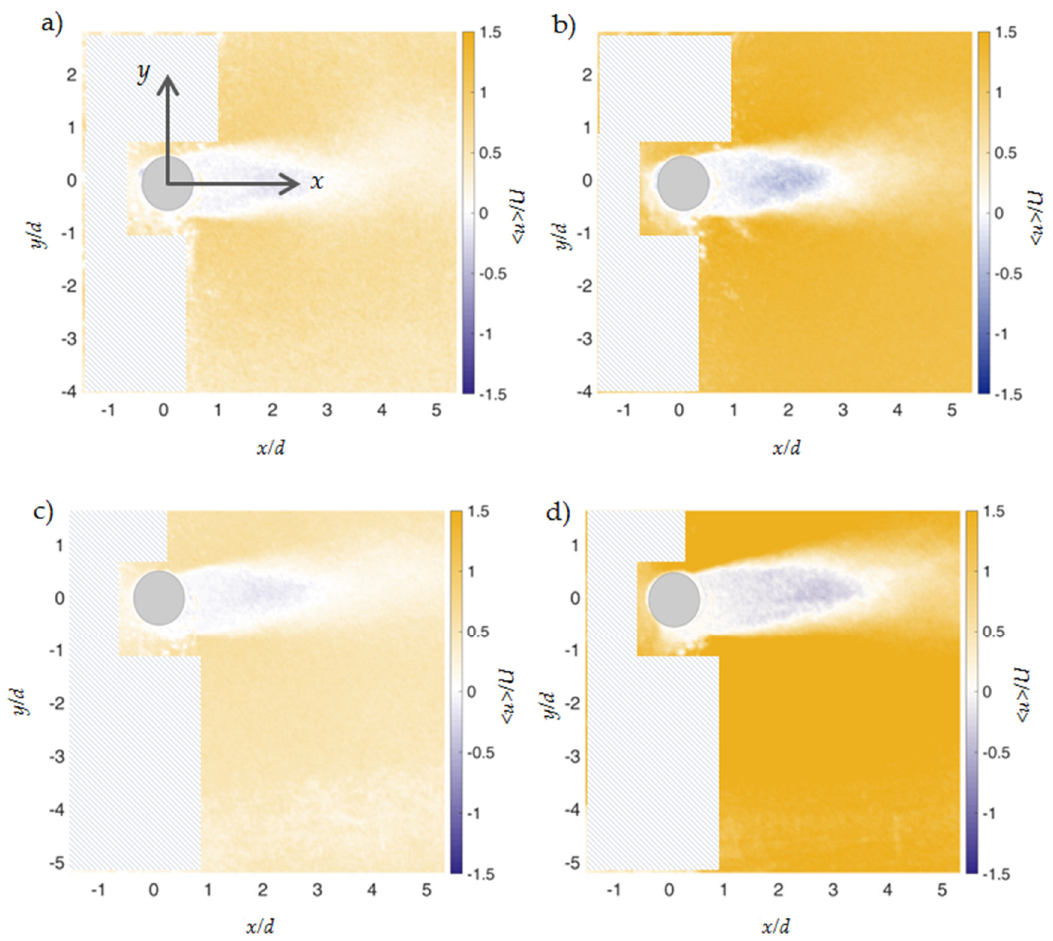
Figure 5. Horizontal maps of the normalized ensemble-averaged streamwise velocity < u > at phases ( a ) W1 trough, ( b ) W1 crest, ( c ) W2 trough, ( d ) and W2 crest. Z axis is vertical and positive upward; here Z = 0.035 m.